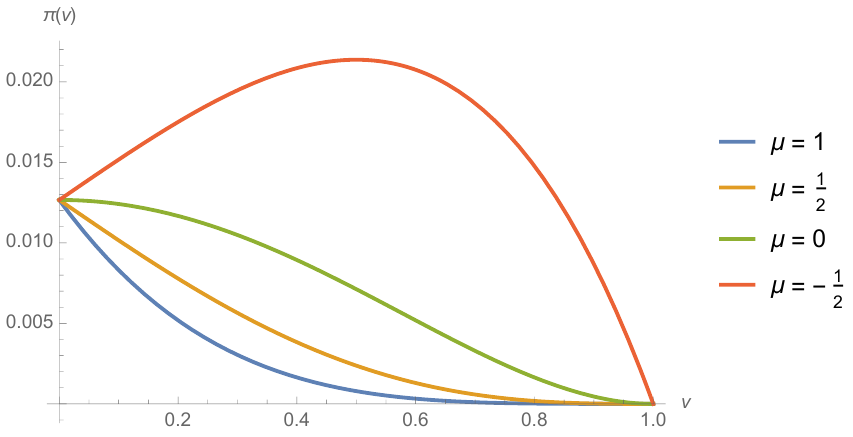
Figure 4 . This plot shows when (cid:22) is non-negative, (cid:25) ( v ) monotonically decreases while (cid:25) ( v ) has an extremum for negative (cid:22)